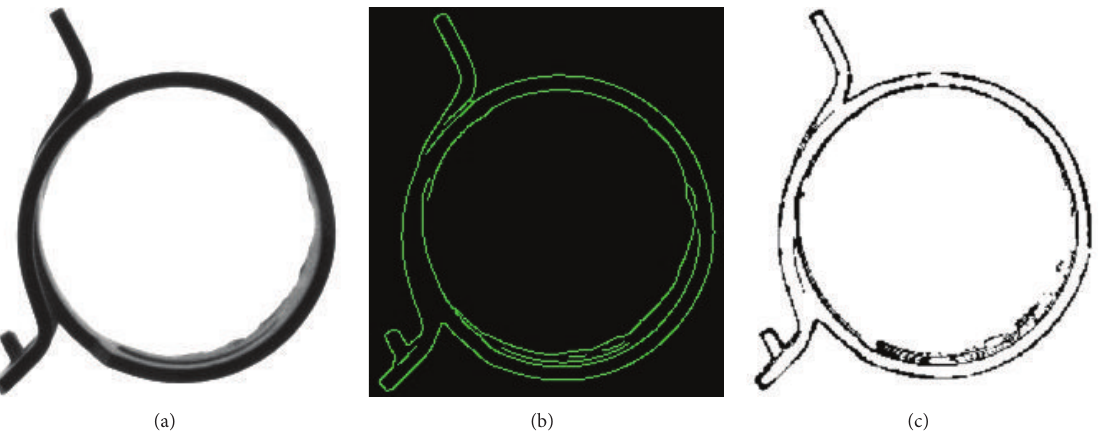
Figure 10: The original image (a), the output image after threshold segmentation (b), and the output image after PCNN segmentation (c).